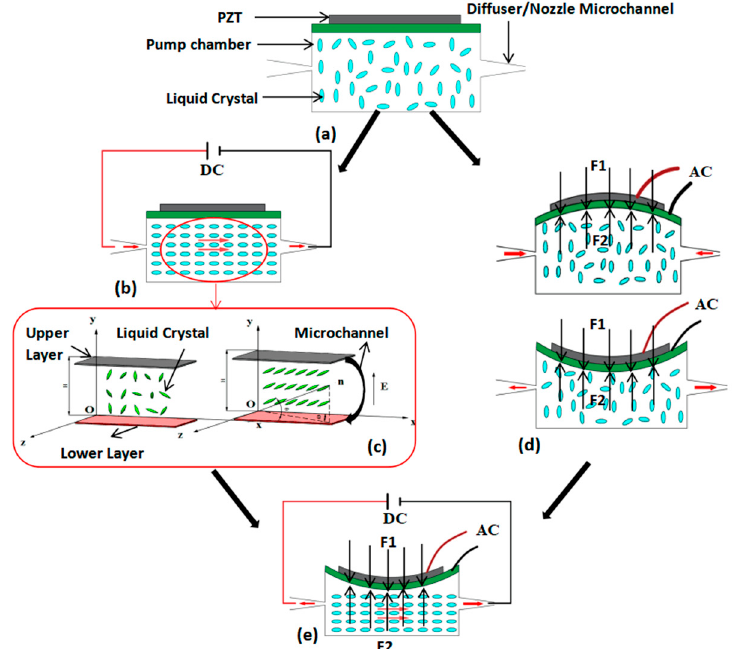
Figure 2. Working principal of the combined driving of piezoelectric transducer and liquid crystal. ( a ) No power supply. ( b ) AC supply. ( c ) The backflow effect of the LC with the AC power supply. ( d ) Inverse piezoelectric effect of the PZT with the DC supply and the supply mode and pump mode for the micropump. ( e ) The net flow of the LC with both AC and DC power supplies.